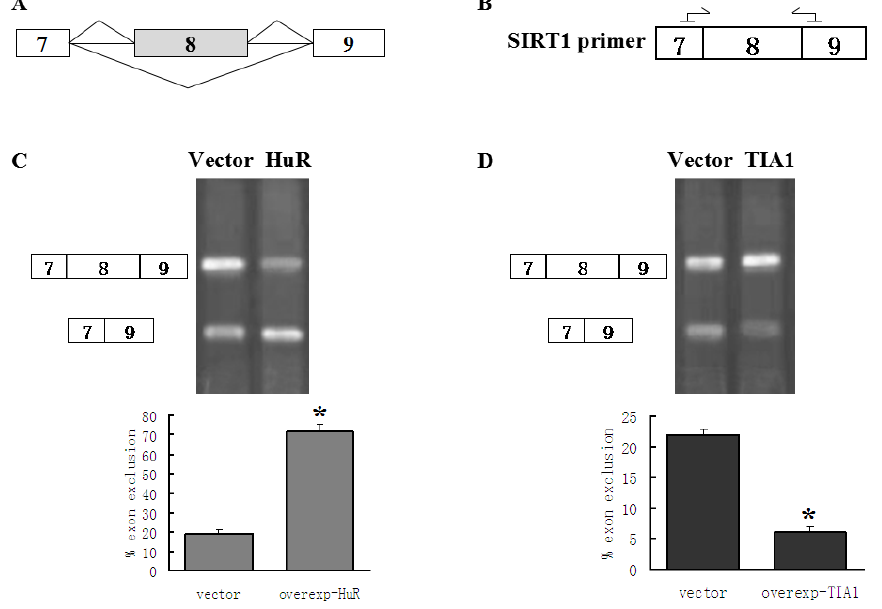
Figure 2. HuR and TIA1/TIAL1 regulate alternative splicing of SIRT1 exon 8 of SIRT1 minigene; ( A ) Schematic structure of SIRT1 minigene, shaded boxes are alternatively spliceable exons; ( B ) The arrows point at the location of the primers of SIRT1; ( C ) HuR caused a significant increase in exon-exclusion for SIRT1 RNAs; ( D ) TIA1 induced SIRT1 minigene exon 8 inclusion. The splicing band patterns were quantified using Image J software [38] and the results showed as below. The results obtained from three